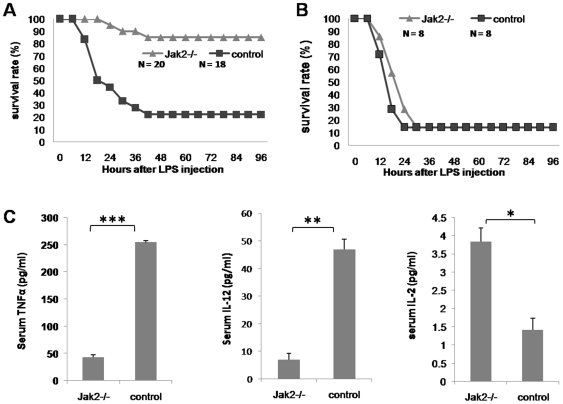

Jak2−/− mice show DC-dependent resistance to lethal dose of LPS-induced septic shock.(A) The survival rates of Jak2−/− and control mice were monitored for 4 days after lethal dose of LPS challenge. It was noticed that mice would completely recover from septic shock if they did not die within 36 h of lethal dose of LPS challenge. 85% of Jak2−/− mice (17 out of 20) have completely recovered from septic shock, while only 22% of control mice (4 out of 18) have survived (p<0.0001). (B) Adoptive transfer of normal DCs into irradiated Jak2−/− mice restored their susceptibility to LPS-induced septic shock. Irradiated Jak2−/− or control mice were first adoptively transferred with 1×107 normal BMDCs followed by lethal dose of LPS challenge. Jak2−/− mice after adoptive transfer of normal DCs showed similar survival rate as that of control mice, indicating that the resistant phenotype for septic shock seen in Jak2−/− mice is DC-dependent. (C) ELISA analysis of serum cytokines of nonlethal dose of LPS challenged mice. Both Jak2−/− and control mice were first challenged with nonlethal dose of LPS (150 µg/mouse) and 12 h later the mice were sacrificed, respectively. Sera were pooled from three mice and then subjected to ELISA analysis of cytokine production. Three pools were analyzed for each study group. Jak2−/− mice produced significant lower levels of proinflammatory cytokines as compared with that of control mice. The data are present as mean ± SE of three replicates. *, p<0.05; **, p<0.01; ***, p<0.001.